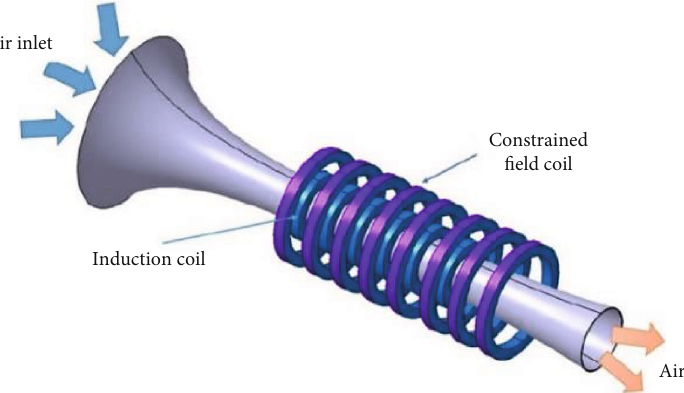
Figure 26: Concept of air-breathing helicon thruster